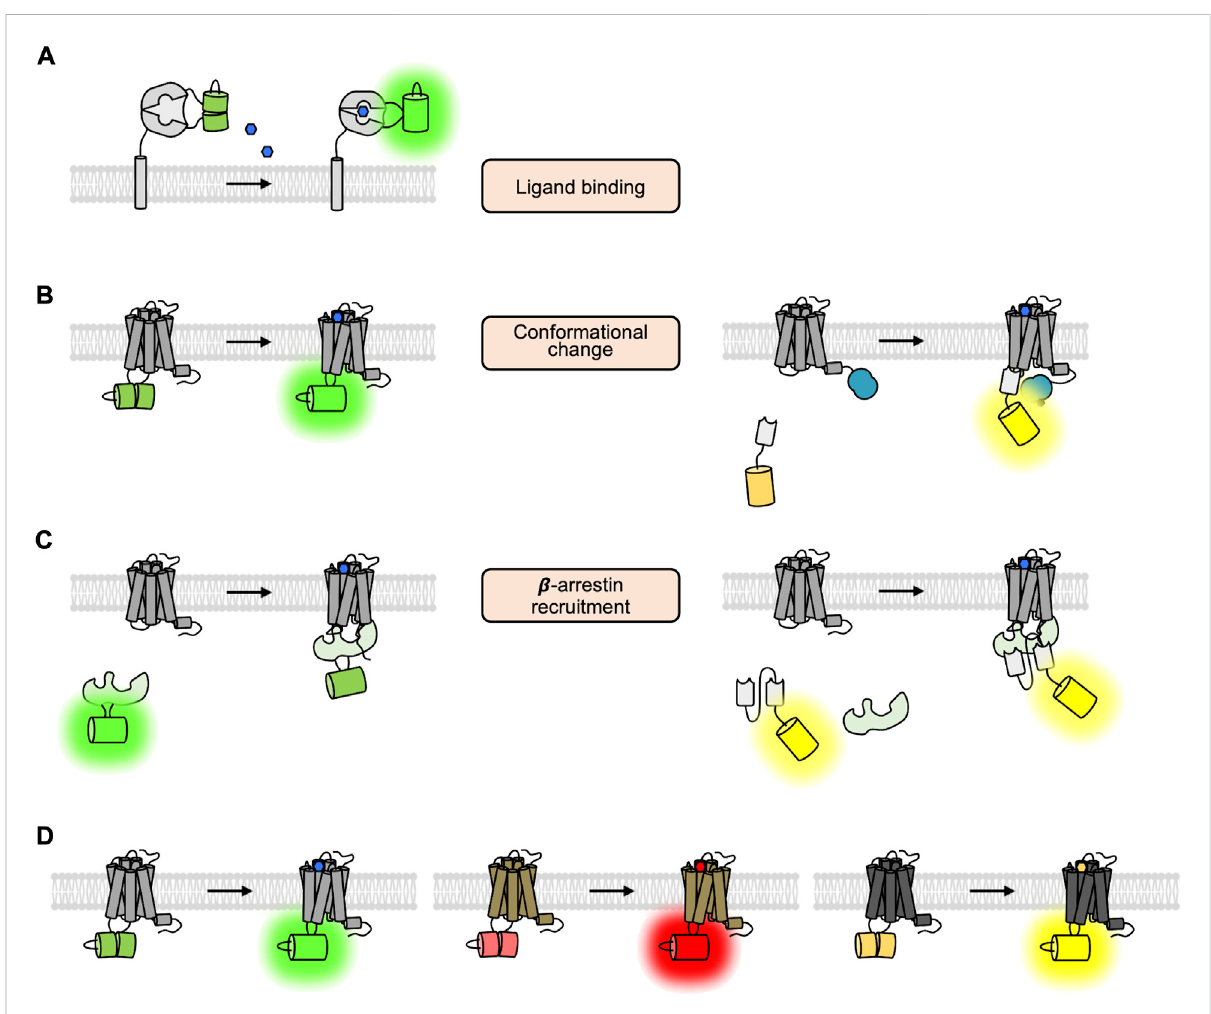
FIGURE 3 The GPCR biosensors utilizing cpFP and nanobody. (A) Schematic design of the ligand-sensing biosensors based on cpFP (Marvin et al., 2013). The fl uorescent signal of cpFP inserted in the ligand-sensing domain is increased upon ligand binding. (B) Schematic design of fl uorescent biosensorsdetectingtheconformationalchangeofGPCRs(Patriarchietal.,2018;Sunetal.,2018).Intheleftpanel,the fl uorescentsignalofthecpFP insertedintheICL3regionoftheGPCRisincreasedupontheconformationalchangeoftheGPCR.Intherightpanel,theYFP-taggednanobody can speci fi cally bind to the GPCR of active conformation. As a luciferase is fused to the GPCR, thus the BRET signal between the YFP and the luciferase is increased. (C) Schematic design of the cpFP- and nanobody-based biosensors detecting the recruitment of G proteins (Hoare et